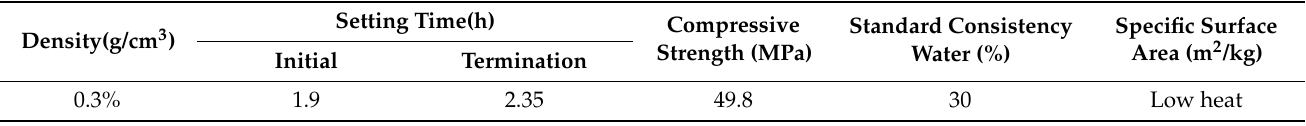
Table 1. Cement main technical parameters.